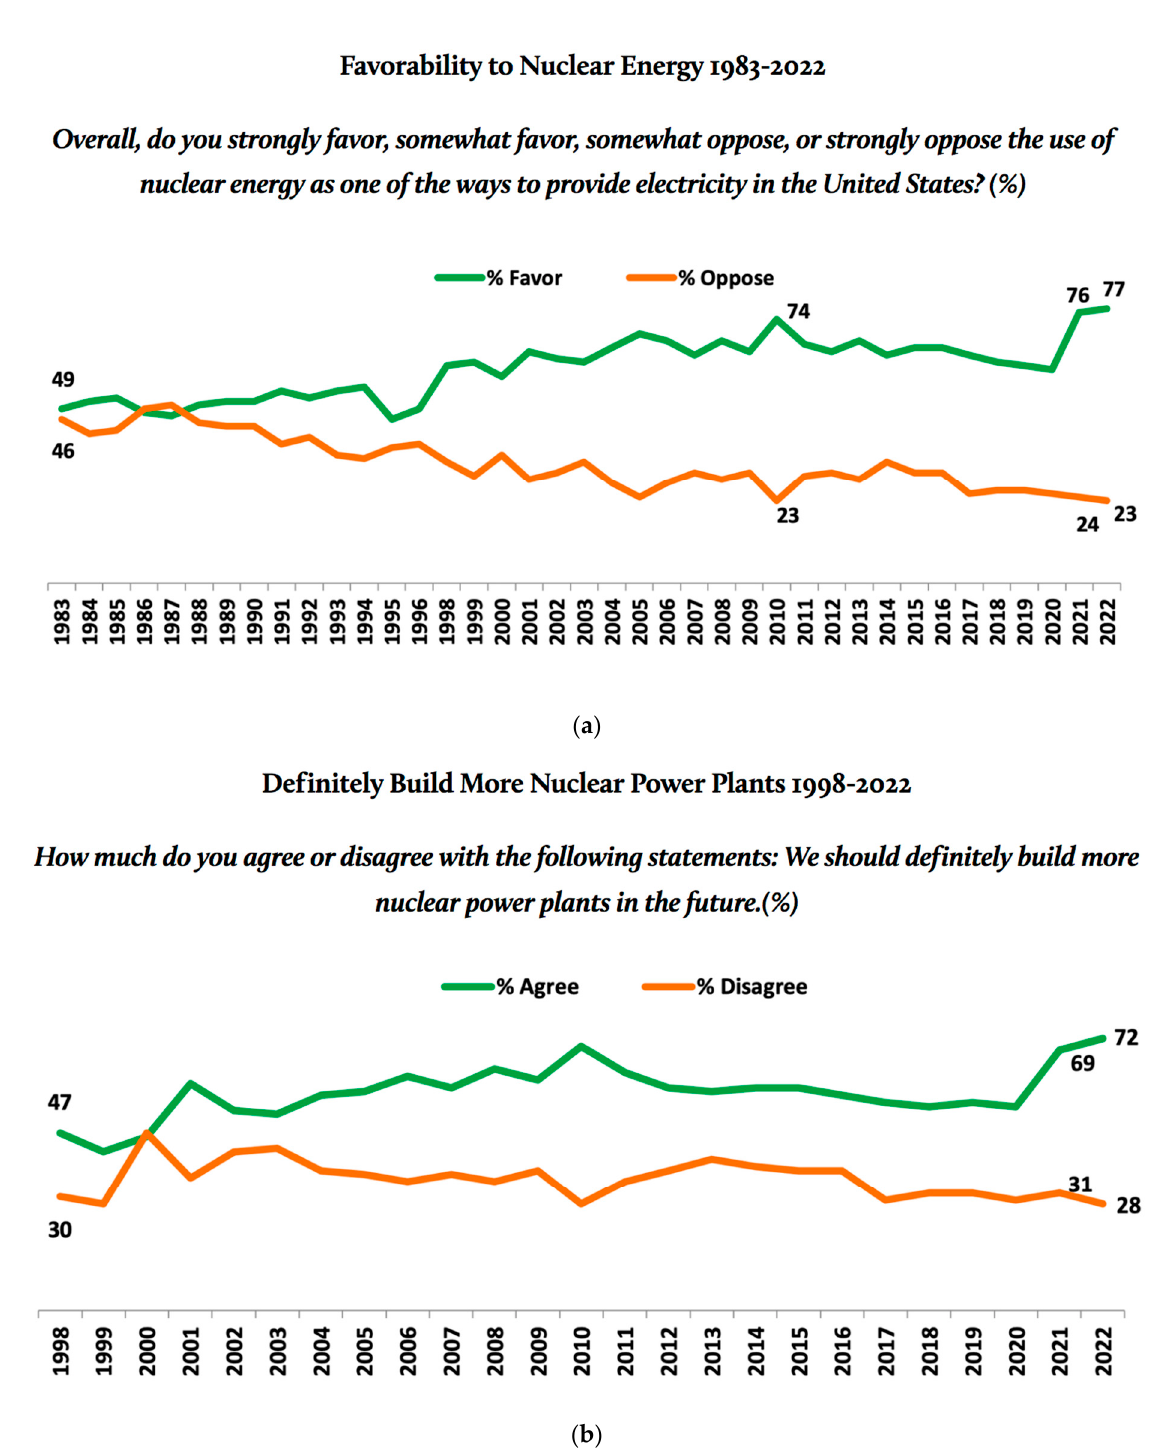
Figure 1. ( a ). Trends for support and opposition to nuclear energy among Americans from 1983 to 2022: Annual averages percentage—Based on data from [133–135]. ( b ). Trends for support and opposition to the construction of new nuclear power plants among Americans from 1998 to 2022: Annual averages percentage—Based on data from [135].